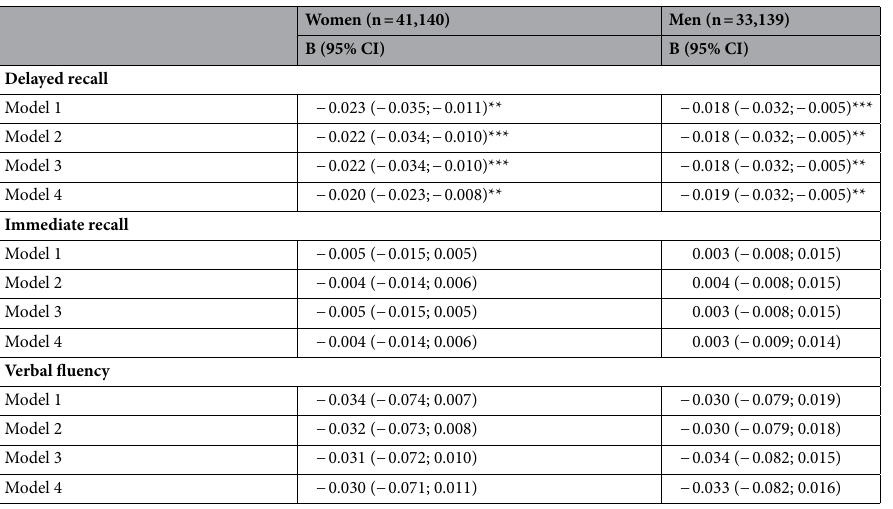
Table 3. Association of childhood socioeconomic disadvantage with the rate of cognitive decline. * p < 0.05, ** p < 0.01, *** p < 0.001. Model 1 adjusted for age and practice effect. Model 2 adjusted for age, practice effect and education. Model 3 adjusted for age, practice effect, education, depressive symptoms and socioeconomic characteristics (household net worth, cohabitation status, number of children, number of grandchildren and current working status). Model 4 adjusted for age, practice effect, education, socioeconomic characteristics (household net worth, cohabitation status, number of children, number of grandchildren, current working status) and health related characteristics (body mass index, depressive symptoms, limitations in instrumental activities of daily living, maximum of grip strength, physical inactivity, number of chronic diseases, smoking status, cardiovascular disease and alcohol use).